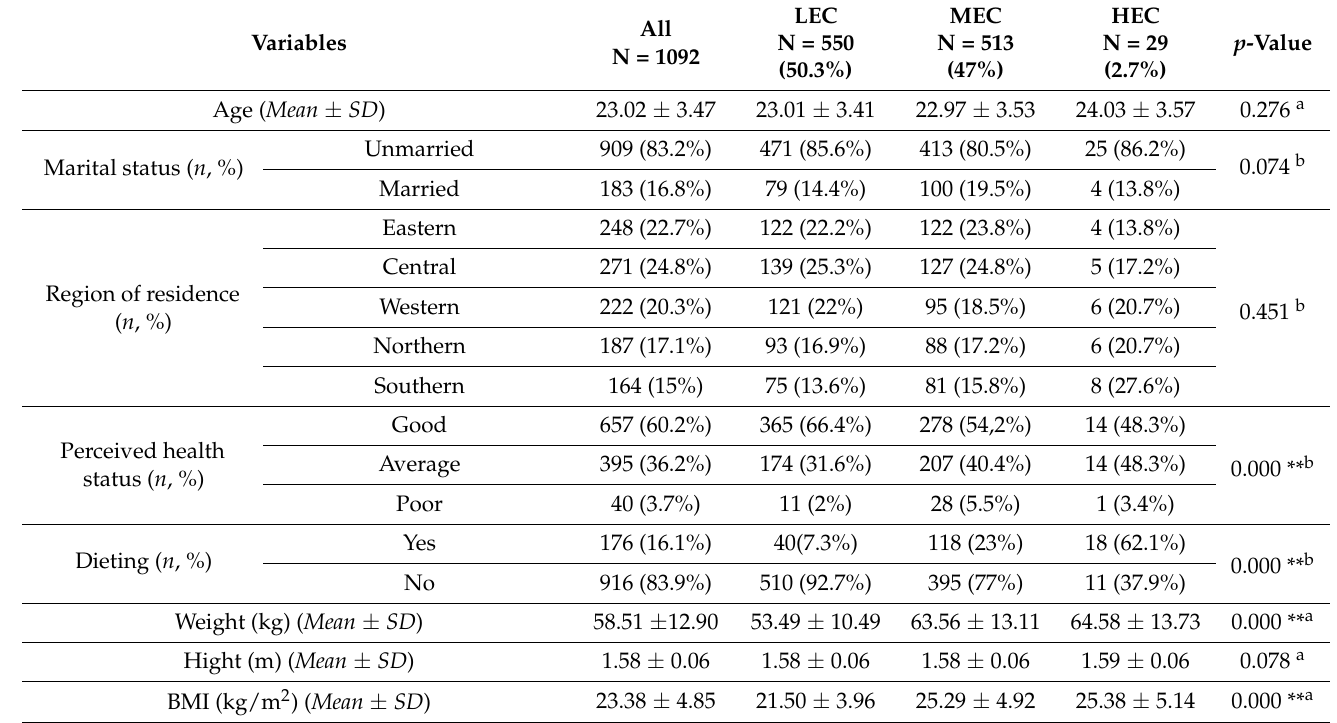
Table 1. Socio-Demographic Characteristics and Anthropometrics of